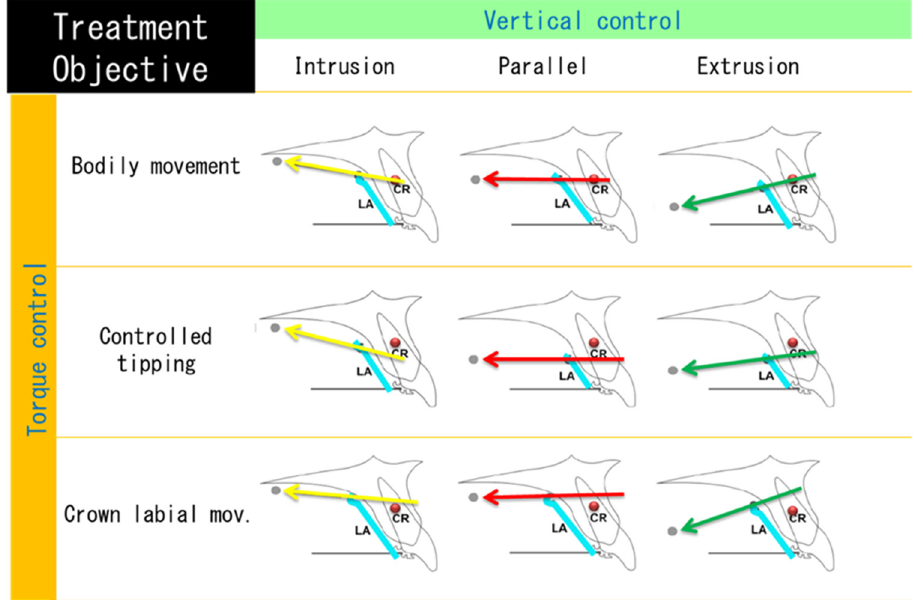
Figure 8. Schematic diagram of the maxillary anterior movement pattern during anterior retraction according to the center of resistance (CR) position of the anterior teeth, the length of the lever arm and the height of the TSAD. Redrawn figure in Angle Orthod [6].